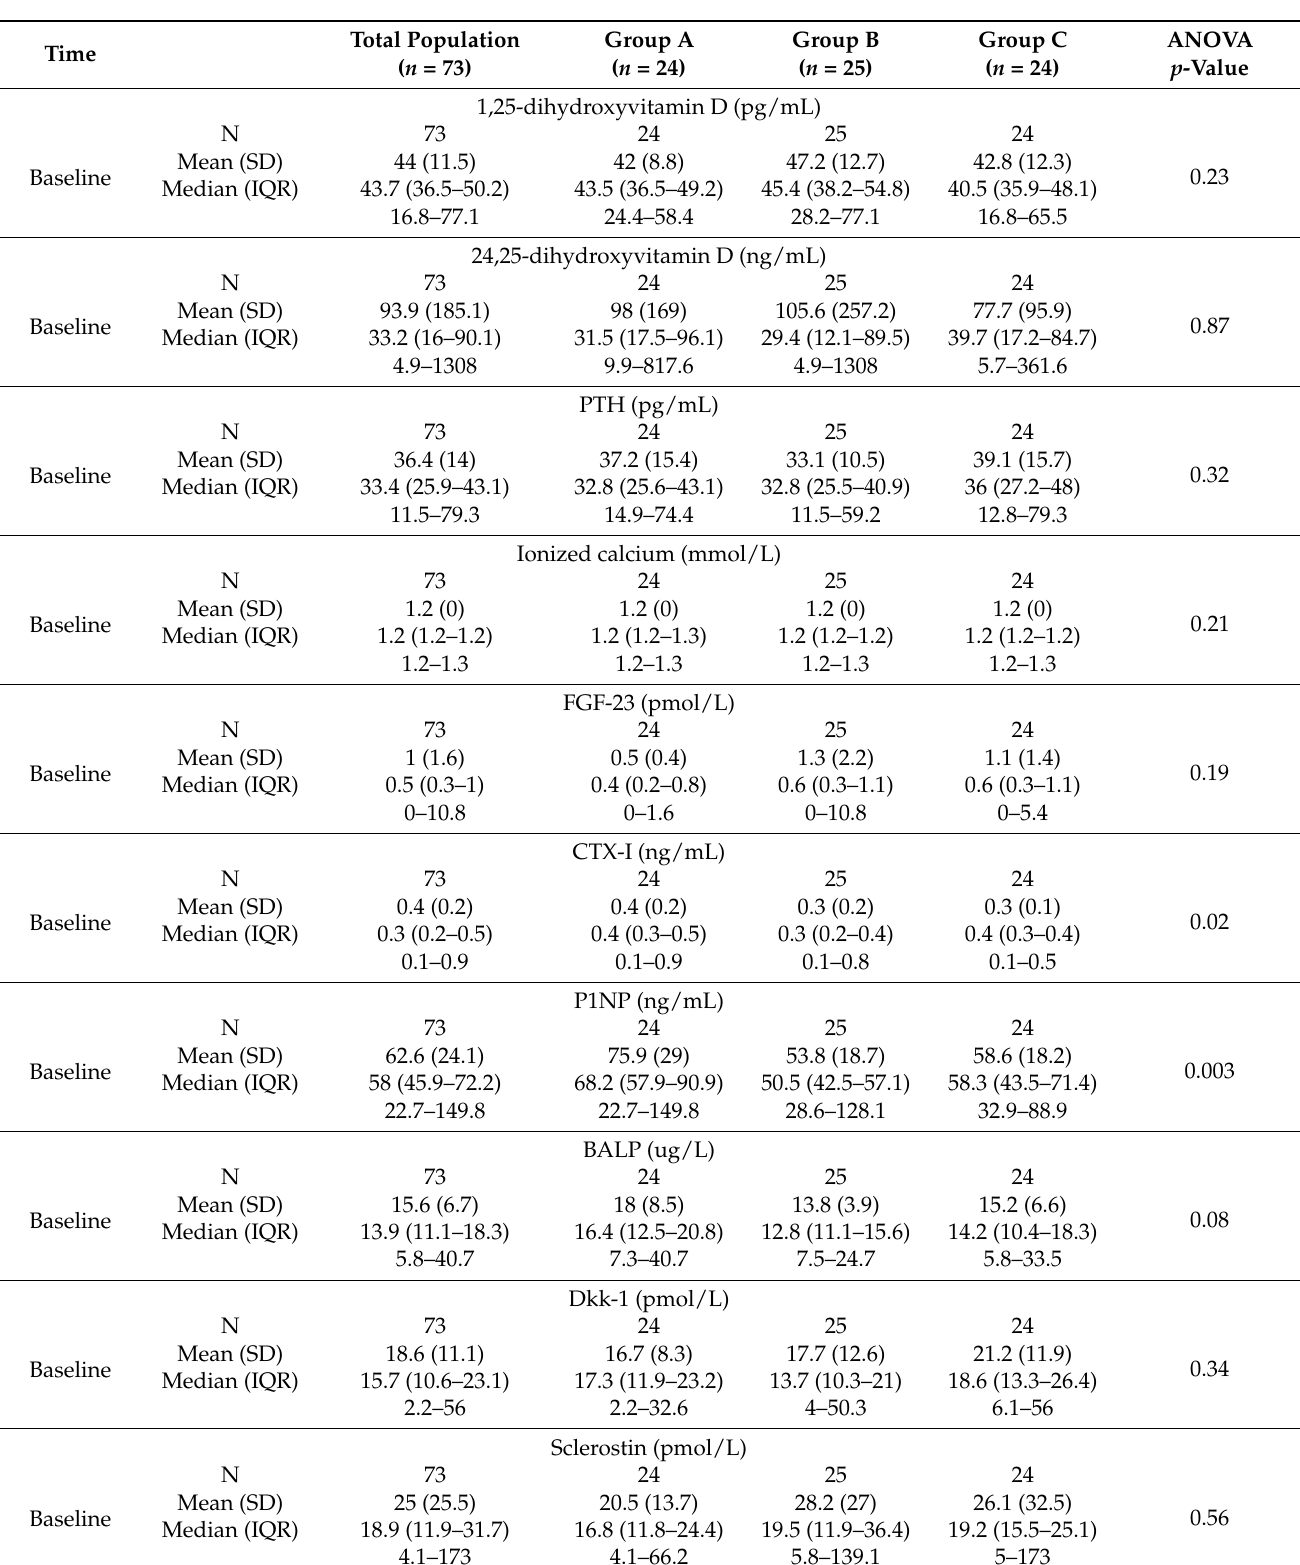
Table 2. Biochemical characteristics at